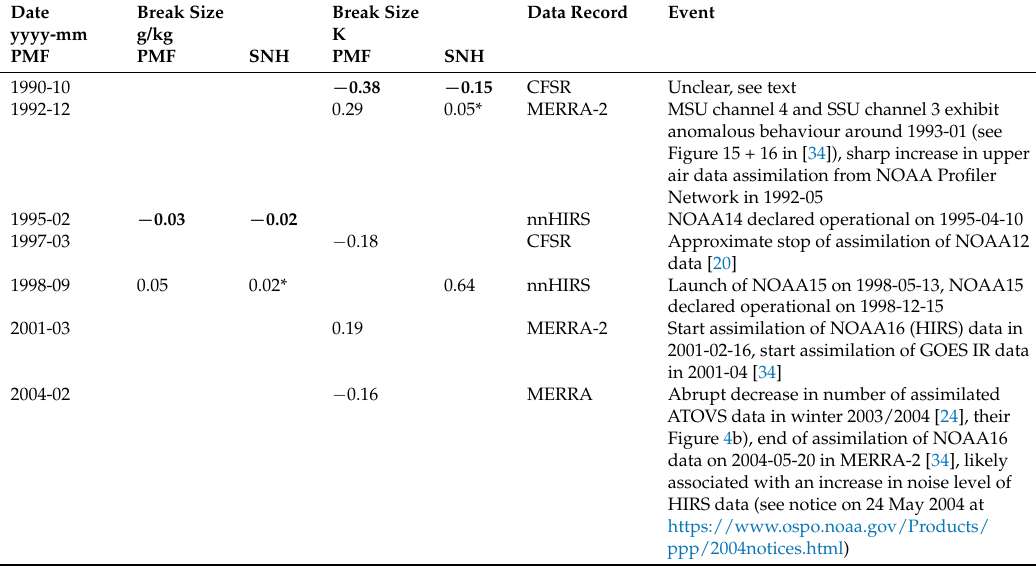
Table 5. As Table 4 but for the region western Africa (300 hPa) (extended and updated from [3]).